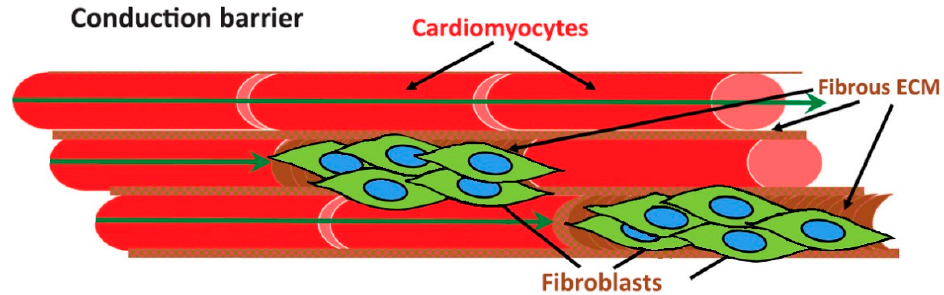
Figure 2. The role of fibroblast–cardiomyocyte interaction for the development of conduction barriers in the atrial myocardium.